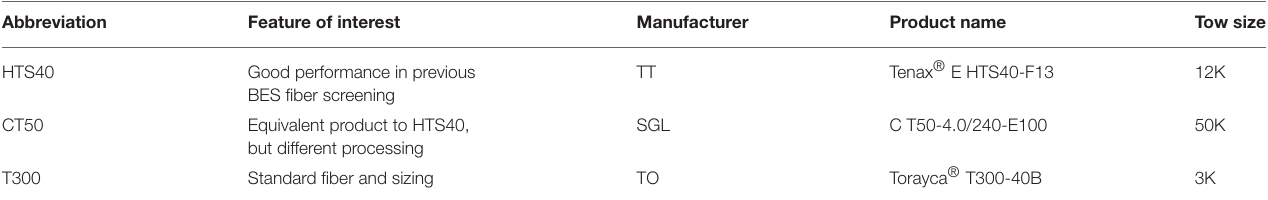
TABLE 1 | Properties of commercial PAN CF used in this